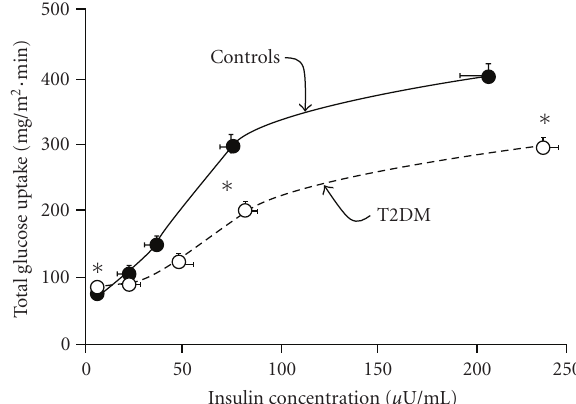
Figure 1: Dose-response curve relating the plasma insulin concen- tration to the rate of insulin mediated wgole body glucose uptake in controls and type 2 diabetic subjects. ∗ P < . 01 (from